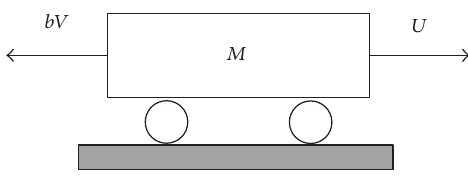
Figure 10: Schematic representation of the cruise control system for a